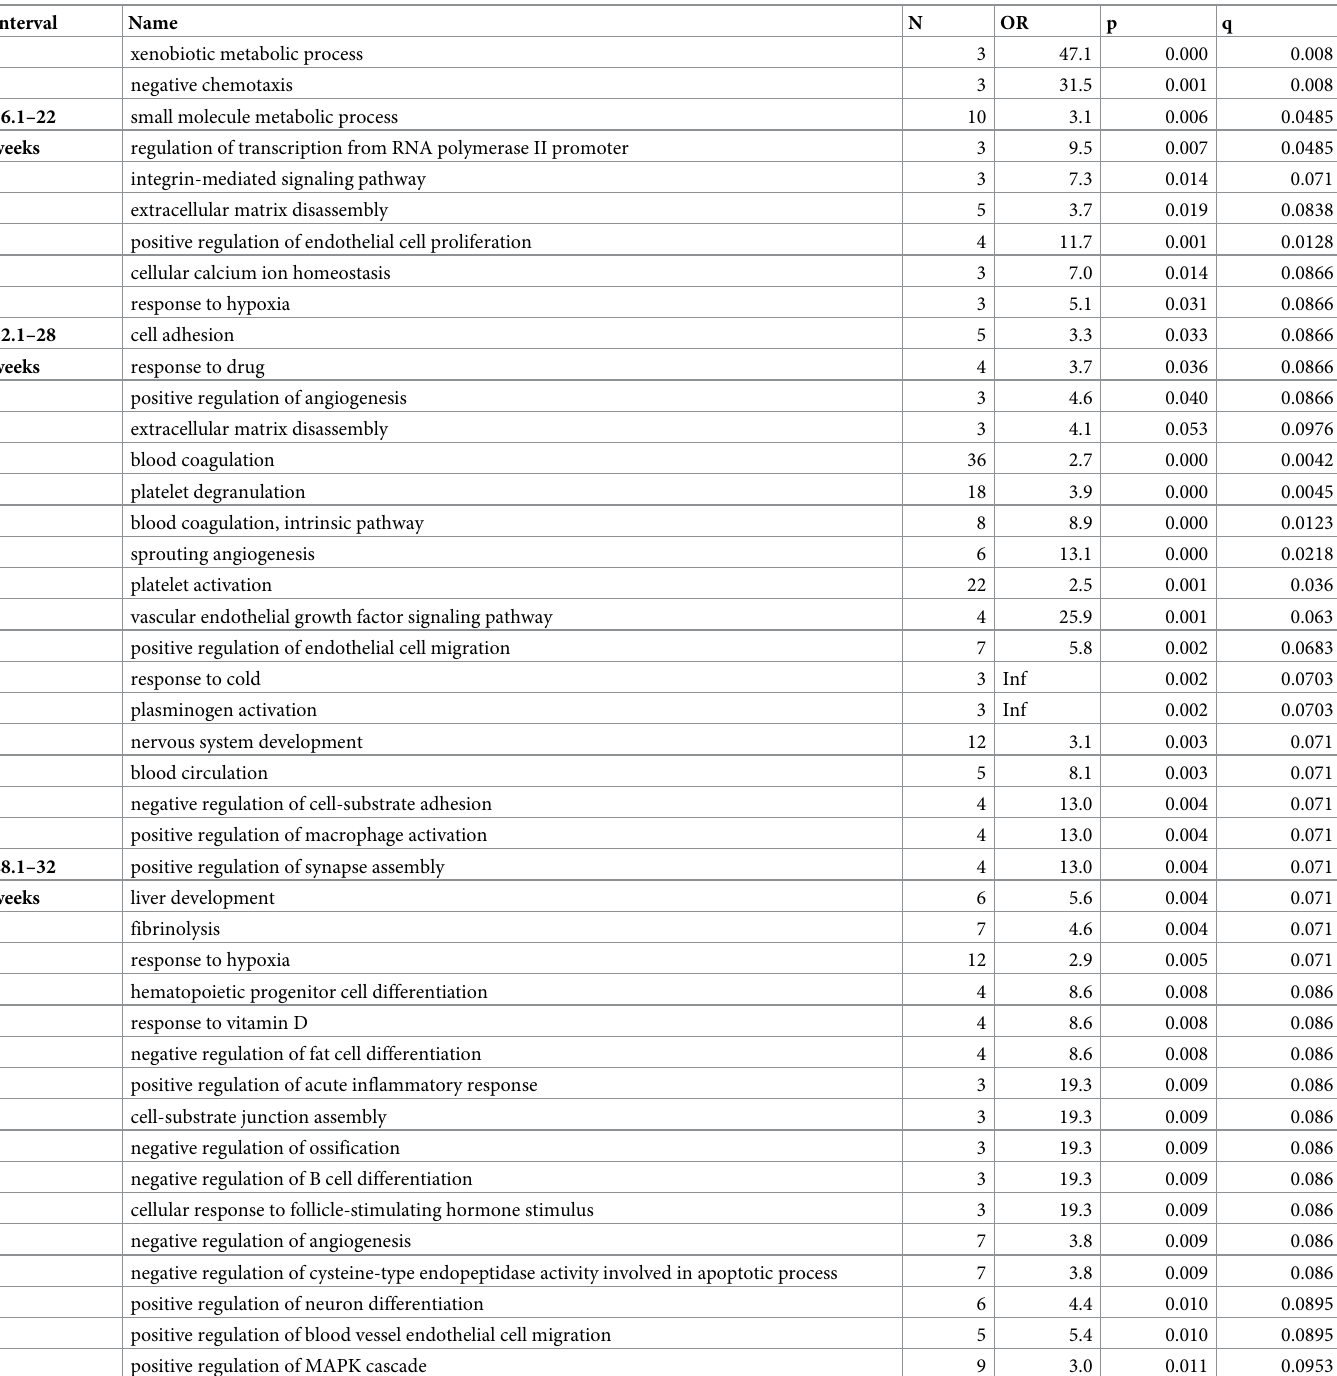
Table 4. Biological processes enriched in proteins with a differential abundance between early preeclampsia and normal pregnancy.